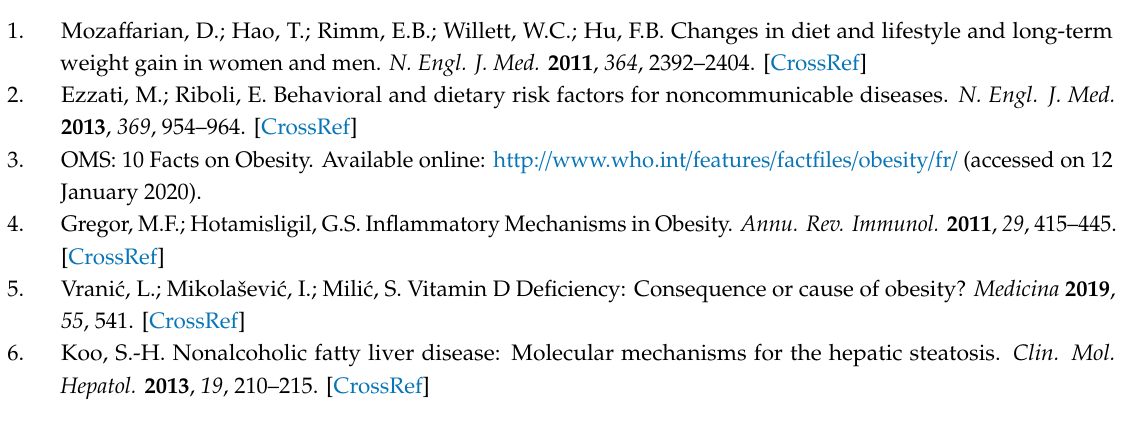
Figure S1: Adipose tissue relative mass after 25-weeks protocol; Figure S2: AUC insulin tolerance test (ITT) values of mice fed with 10 weeks of high-fat / high-sucrose diet; Table S1: Primers